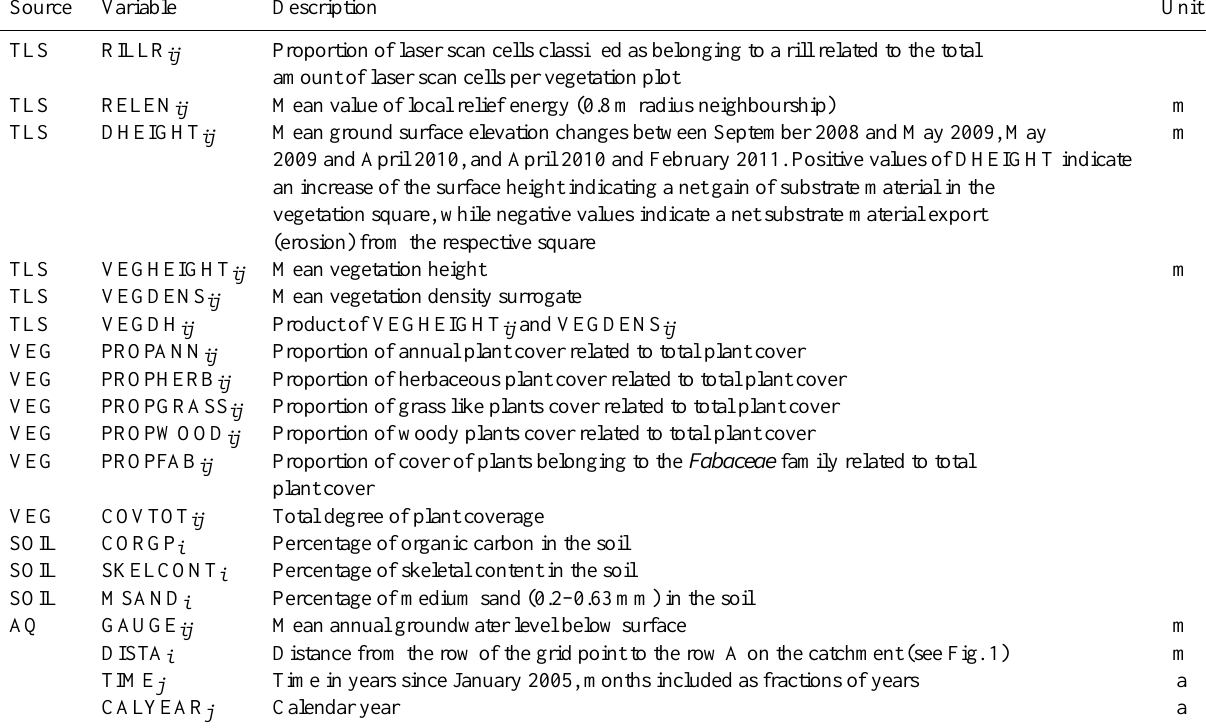
TLS: derived from laser scans, available for each laser scan grid cell, aggregated for each vegetation plot. VEG: derived from the vegetation monitoring, summer of each year. SOIL: values from soil samples in 2005 at the centre of each vegetation plot. AQ: values assigned from the nearest of the groundwater gauges, yearly averages. Indices: i values for a specific location (grid point), constant over time. j values for points in time, spatially independent. ij values for a specific point in time, at a specific location.